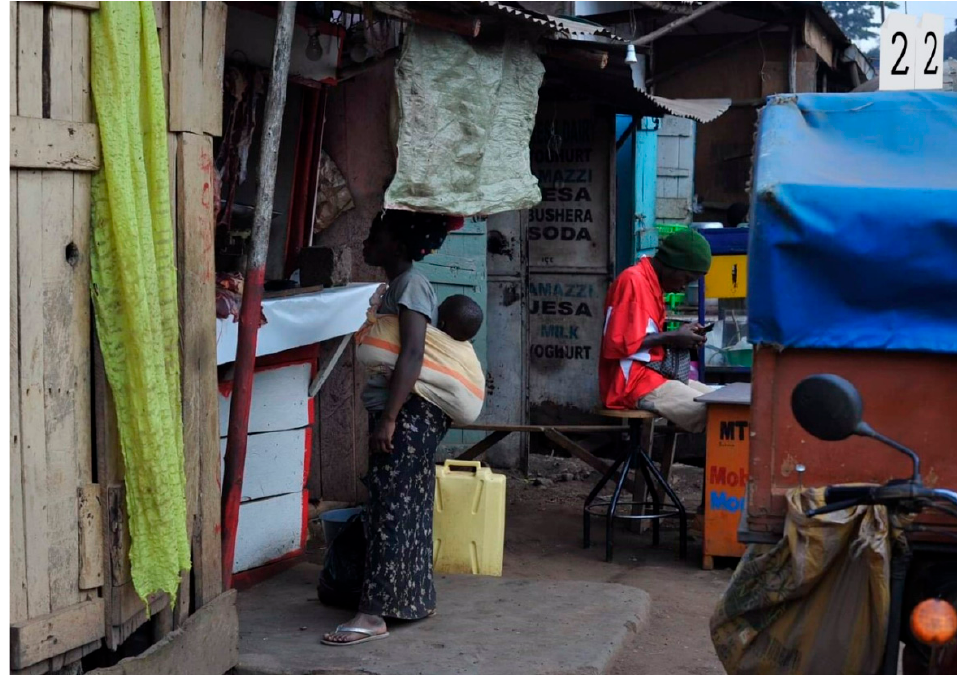
Figure 7. Mother With Child Shopping (photo number 22). Table 1. Participants’ Group Response to 25 Photos of Places within Urban Slums that are Linked to Mental Health and Elicit an Emotional Response.